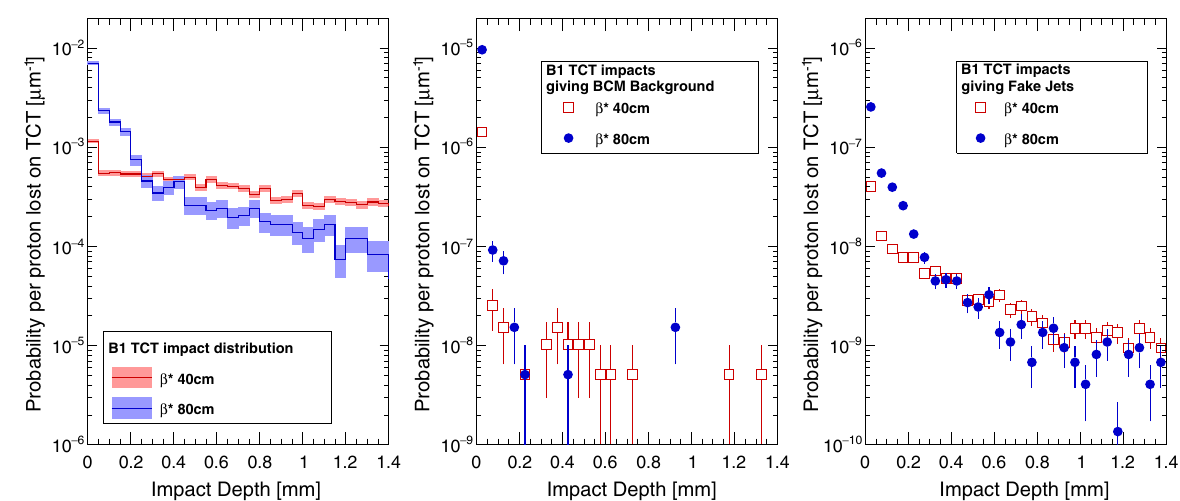
FIG. 12. Distribution of the transverse depth of the inelastic interactions inside the jaws of the TCTs in B1 at β (cid:1) ¼ 40 cm and β (cid:1) ¼ 80 cm for a superposition of horizontal and vertical losses in IR7. The probabilities, obtained from the simulations, are averaged over 50 μ m wide bins. The TCTapertures are 8 . 8 σ and 13 . 7 σ at β (cid:1) ¼ 40 cm and β (cid:1) ¼ 80 cm, respectively. The hits in the horizontal and vertical TCTs are summed. The left plots show the distribution of all impacts. The middle and right plots show only those impacts that have resulted in a BCM background signature or a fake jet,